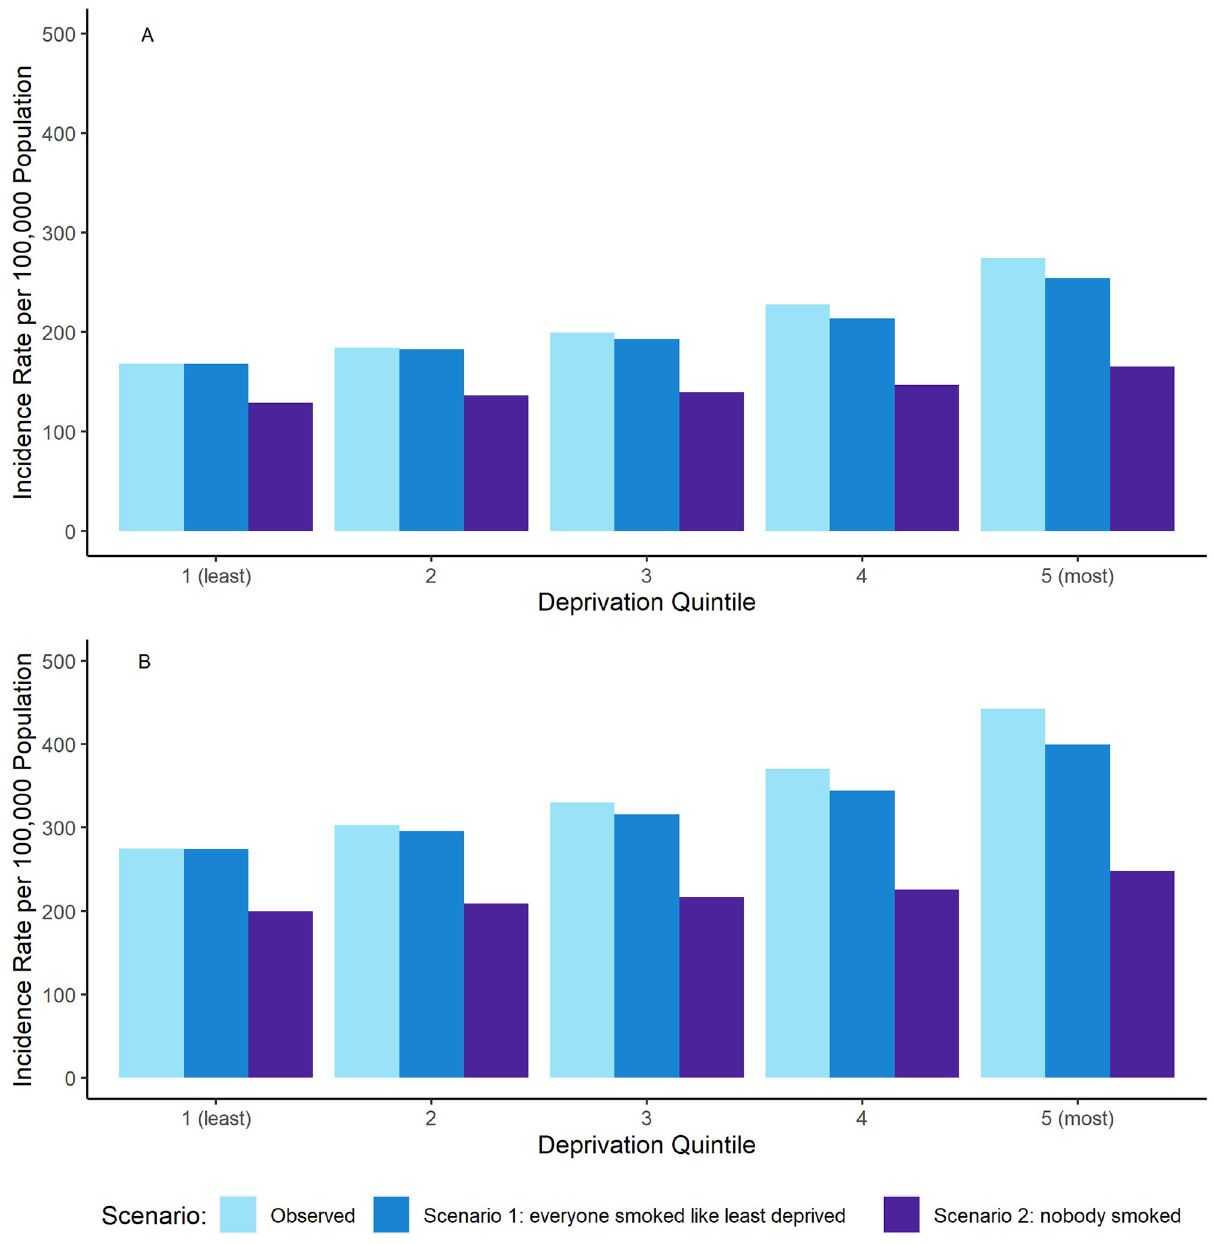
Fig 2. A (females) and B (males). Combined European Age-Standardised incidence rates (ASR) per 100,000 population for smoking-related cancer types � by deprivation quintile and sex, for observed cancer incidence (the current situation), scenario 1 and scenario 2, England, 2013–2017. � oral cavity, pharynx, nasopharynx, larynx, oesophagus, stomach, colorectal, liver, pancreas, lung, cervix uteri, kidney, bladder, ovarian (mucinous) and leukaemia (acute